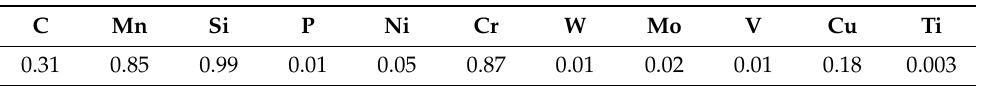
Table 1. Chemical composition and weight percent of 30CrMnSiA steel (wt %). (Reproduced with permission from Liu, Crack initiation and propagation of 30CrMnSiA steel under uniaxial and multiaxial cyclic loading, published by Elsevier, 2019.)